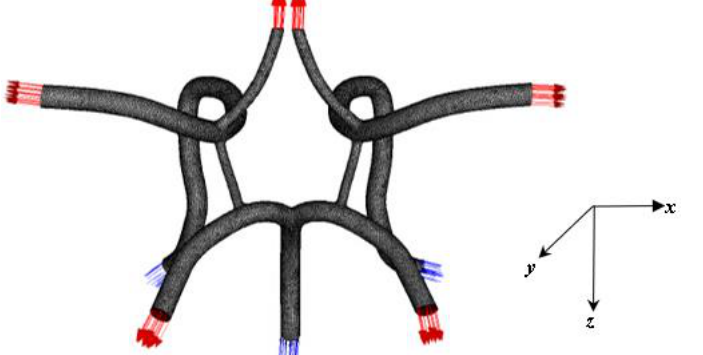
Figure 17. Computational CoW arterial mesh (coarsest mesh).